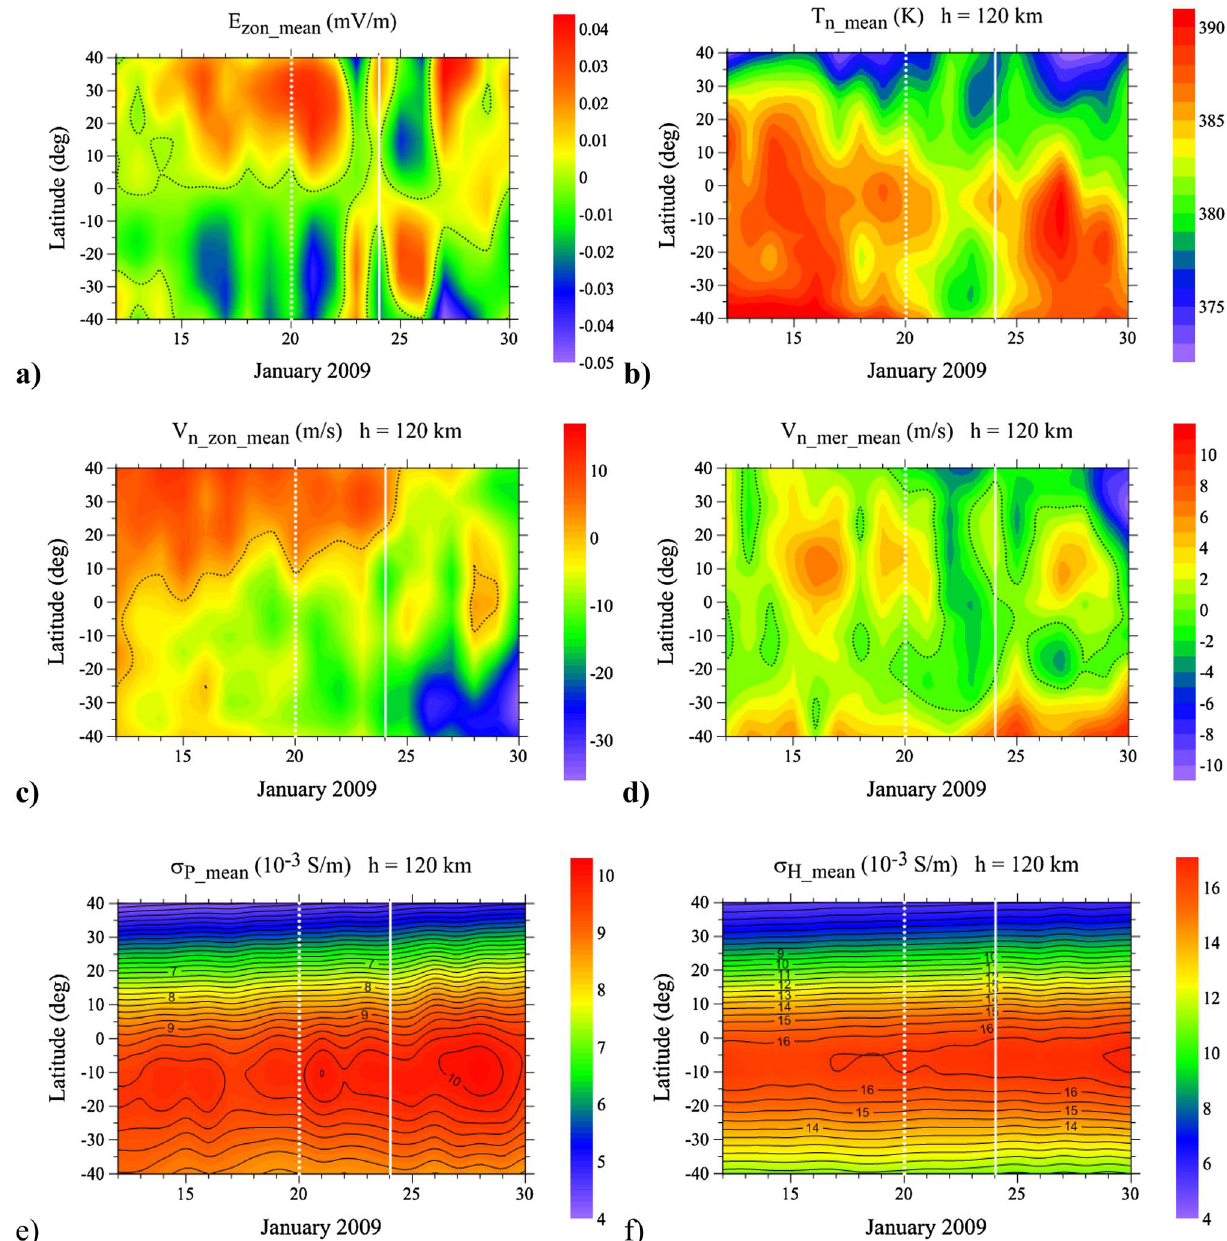
Fig. 2. EAGLE-simulated day-to-day variability of daily averaged zonal mean anomalies in (a) zonal electric fi eld, (b) neutral temperature, (c) zonal, and (d) meridional wind velocity, (e) Pedersen, and (f) Hall conductivities at 120 km altitude during January 2009. Vertical lines indicate the onset (dotted) and peak (solid) of the 2009